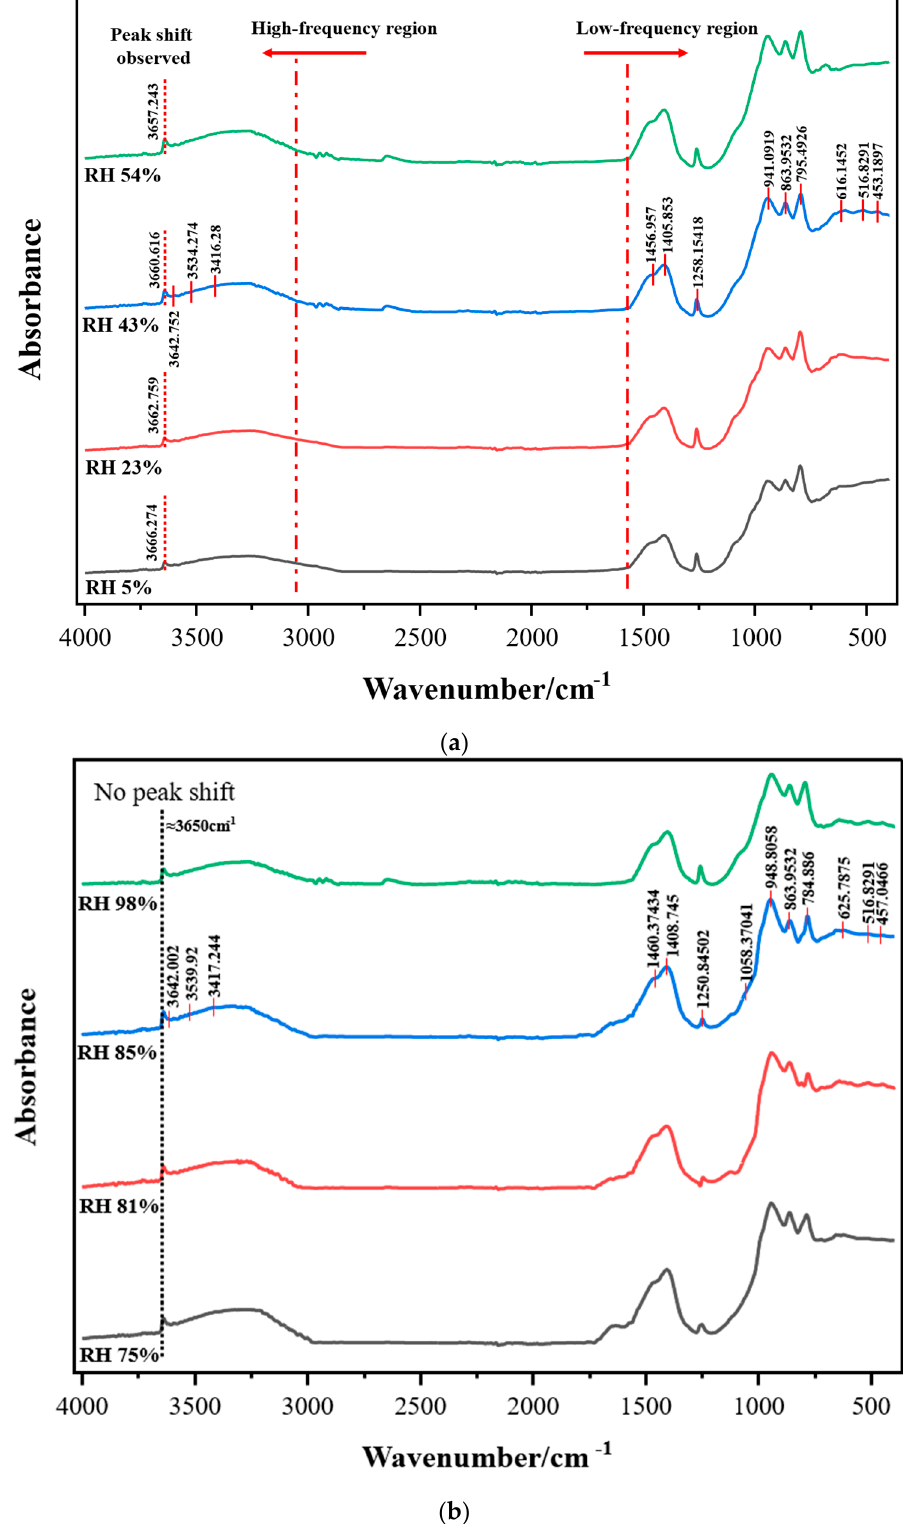
Figure 6. FTIR results of the samples cured at different ambient RHs. ( a ) Results of the samples cured at RHs from 5% to 54%; ( b ) results of the samples cured at RHs from 75% to 98%. Chemically bound water in cement hydration products mainly contains two parts: the crystal water of the compound and the metal ‐ or silicon ‐ bonded hydroxyl groups [32]. Through the spectral line results in the mid ‐ infrared region (MIR) (Figure 6a,b), the diffuse